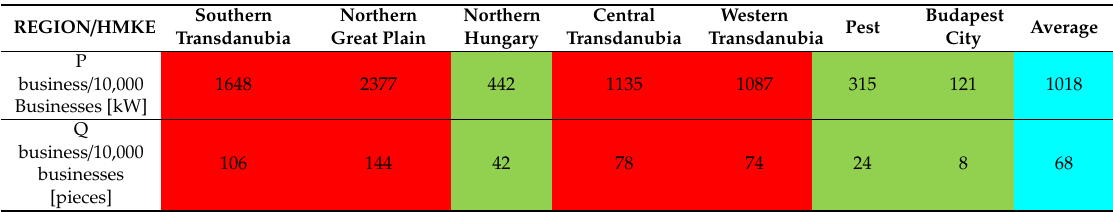
Table 7. Business HMKE figures relative to population size in the seven examined regions of Hungary (red: above the average, green: under the average, blue: